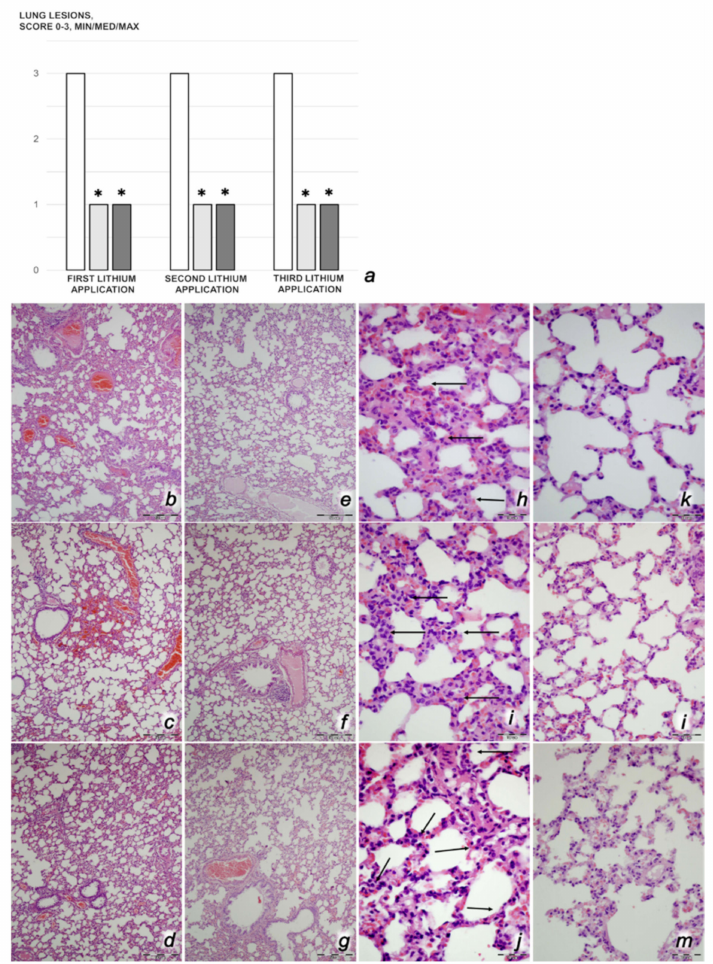
Figure 5. Lung pathology. ( a ) Microscopy scoring of the lesions of the lung (scored 0–3) Min/Med/Max, in the rats treated with lithium sulphate (500 mg/kg/day intraperitoneally for 3 days) that received medication (BPC 157 10 µ g/kg (light gray bars), 10 ng/kg (dark gray bars); saline 5 mL/kg (white bars)) given intraperitoneally. Six rats/group/interval. * p < 0.05, at least, vs. control. Lung histology in control lithium-treated rats ( b – d , h – j ) and BPC 157 lithium-treated rats ( e – g , k – m ); first lithium application ( b , e , h , k ); second lithium application ( c , f , i , l ); third lithium application ( d , g , j , m ). A marked congestion was found in controls after each of the lithium adminis- trations, with increased appearance of intra-alveolar hemorrhage found after the second and third lithium administrations. Contrarily, lithium-treated rats that received BPC 157 regimens presented mild congestion of the lung. Interstitial neutrophil infiltration appeared in controls after each of the lithium administrations (arrows), particularly after the second and third lithium administrations. Contrarily, lithium-treated rats that received BPC 157 regimens presented thin and no inflammation within alveolar septa (HE; magnification × 100, scale bar 50 µ m ( b – g ); magnification × 400, scale bar 10 µ m ( h – m